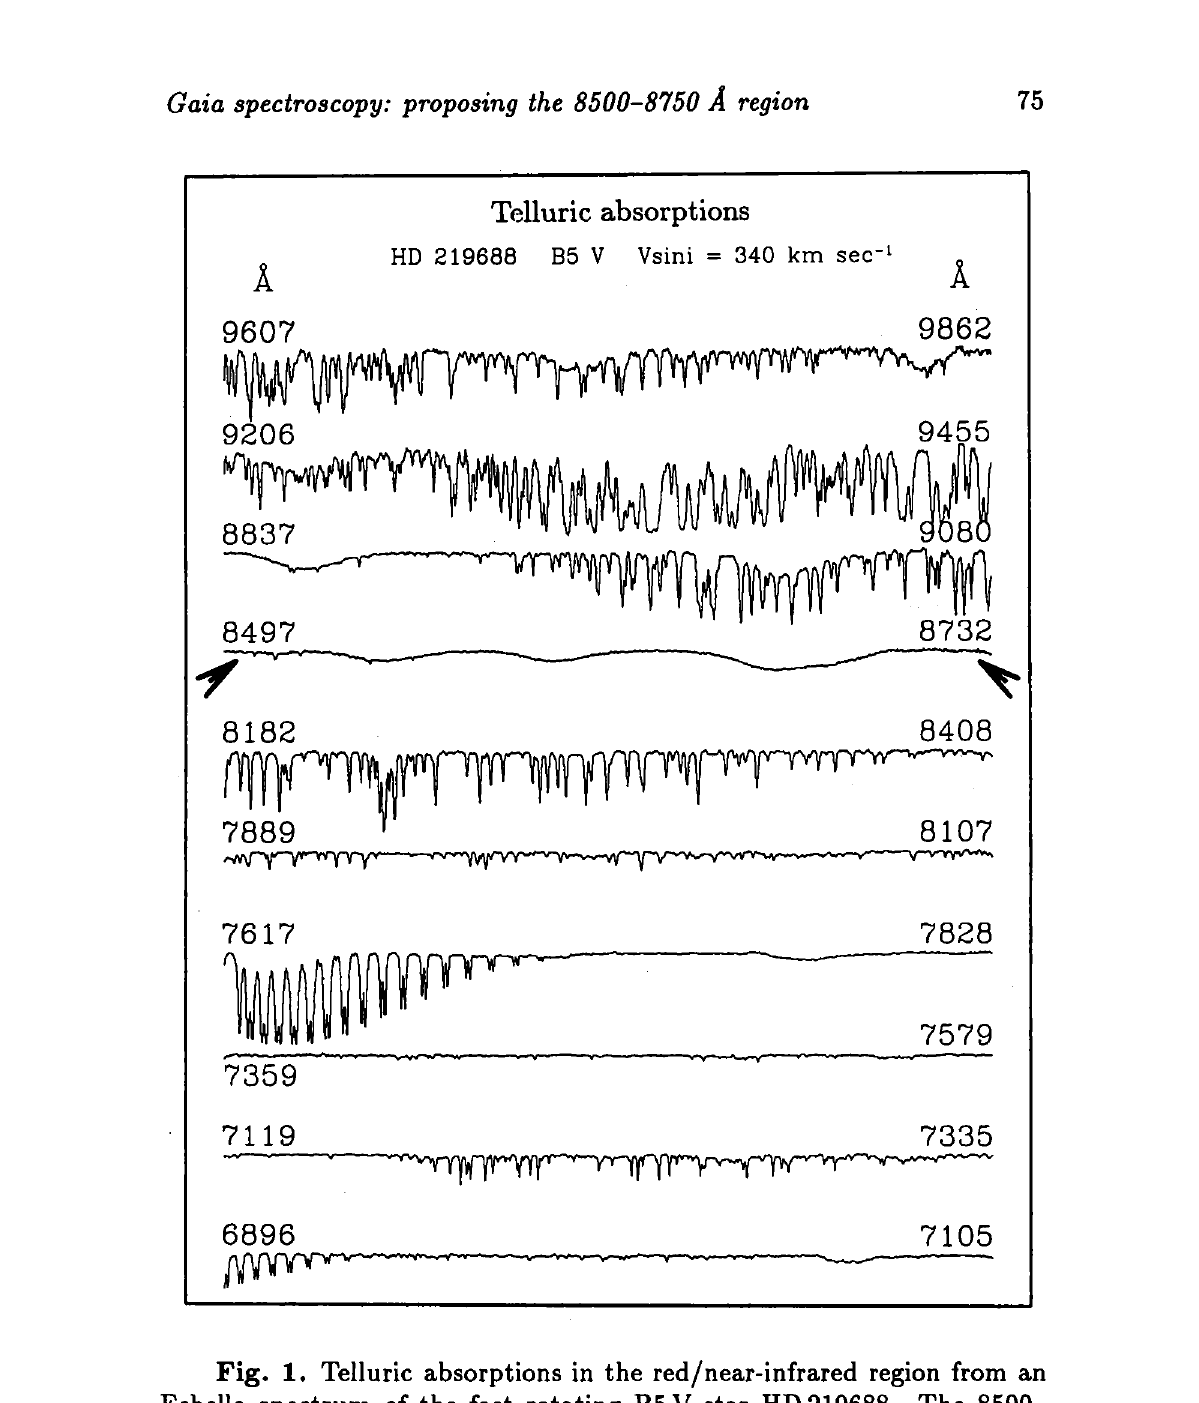
Fig. 1. Telluric absorptions in the red/near-infrared region from an Echelle spectrum of the fast rotating B5 V star HD 219688. The 8500- 8750 Á interval, proposed for Gaia (indicated by the arrows), is clearly less affected by Earth's atmosphere. The stellar absorption lines are very broad and shallow, while all sharp lines are of telluric